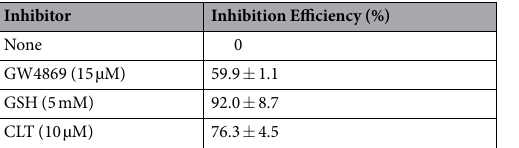
Table 3. Inhibition of Pb(II)-induced hemolyisis. Average values ± S.E.M. (n = 3). Data obtained as detailed under Methods.